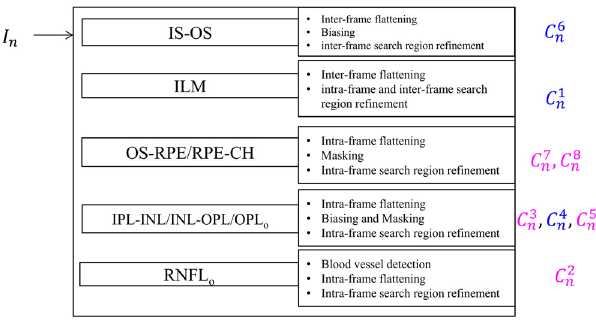
Fig 6. The overview of OCTRIMA 3D framework. The boundaries labeled using blue and red fonts have the dark-to-bright and bright-to-dark transitions, respectively.